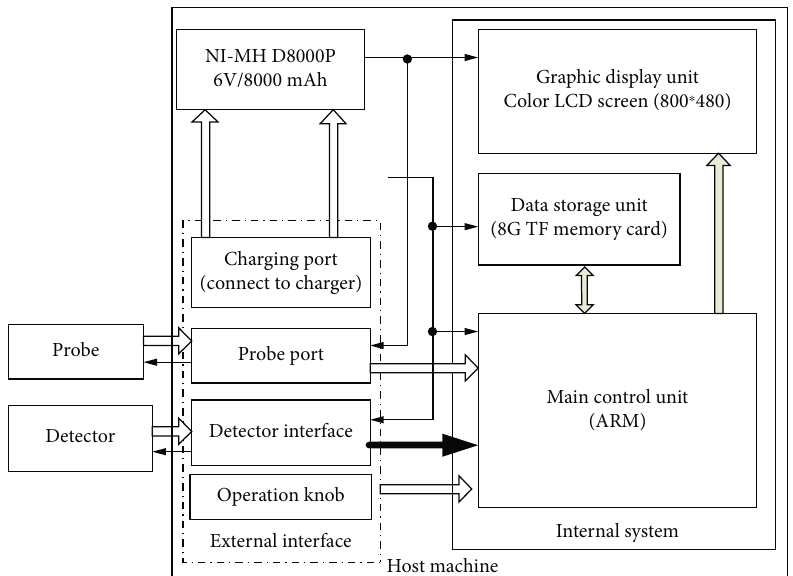
Figure 4: Block diagram of host